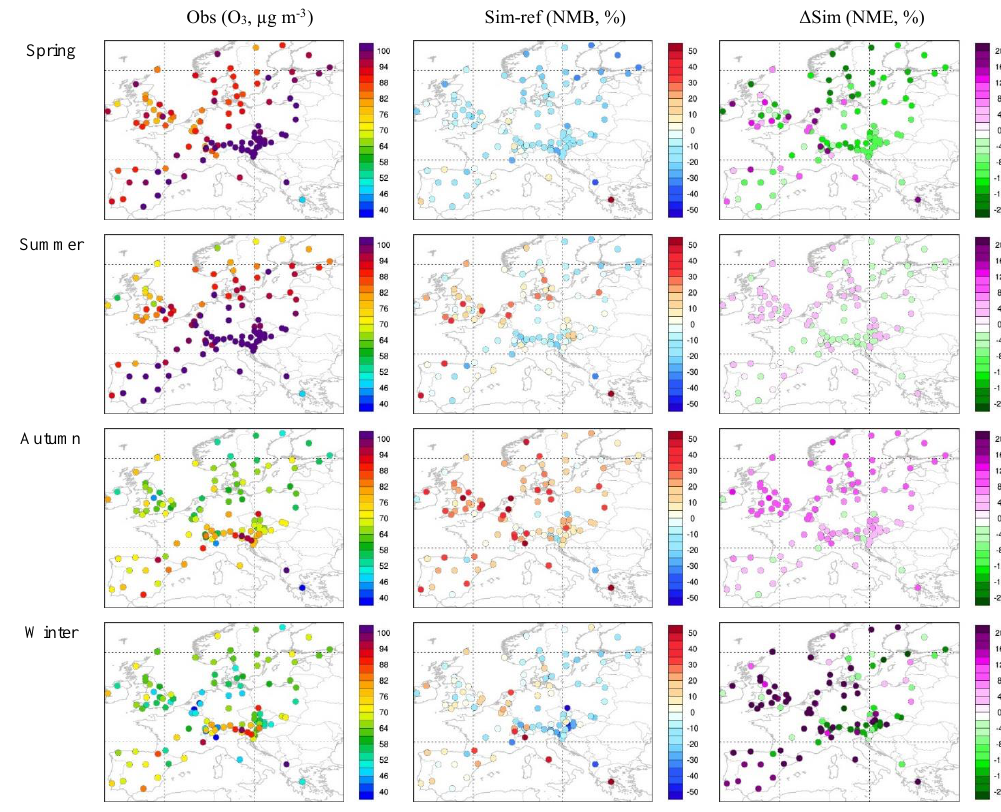
Figure 7. Comparison with EMEP surface daily maximum 8h average O 3 concentrations ( (cid:49) Sim = Sim-new minus Sim-ref in